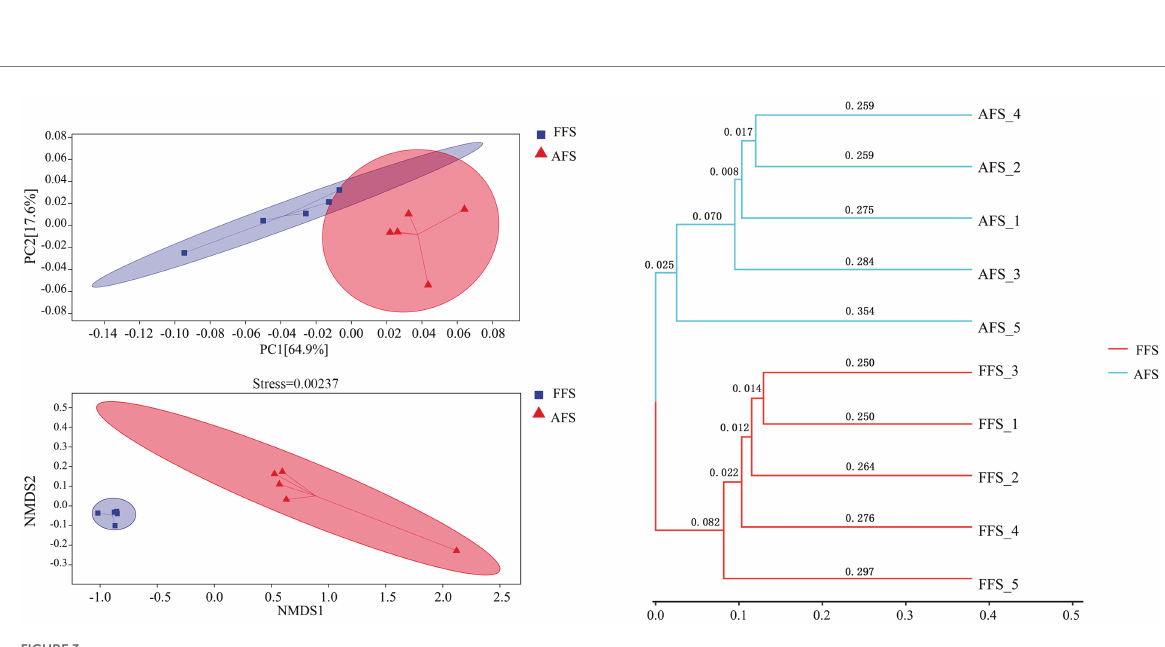
FIGURE 3 Principal coordinates analysis (PCoA) and non-metric multidimensional scaling analysis (NMDS) based on Bray–Curtis distance represent the differences in the soil bacteria between the FFS and the AFS. The hierarchical cluster analysis shows clusters of bacterial communities based on weighted UniFrac with 100% support at all nodes. Different colored shapes represent different